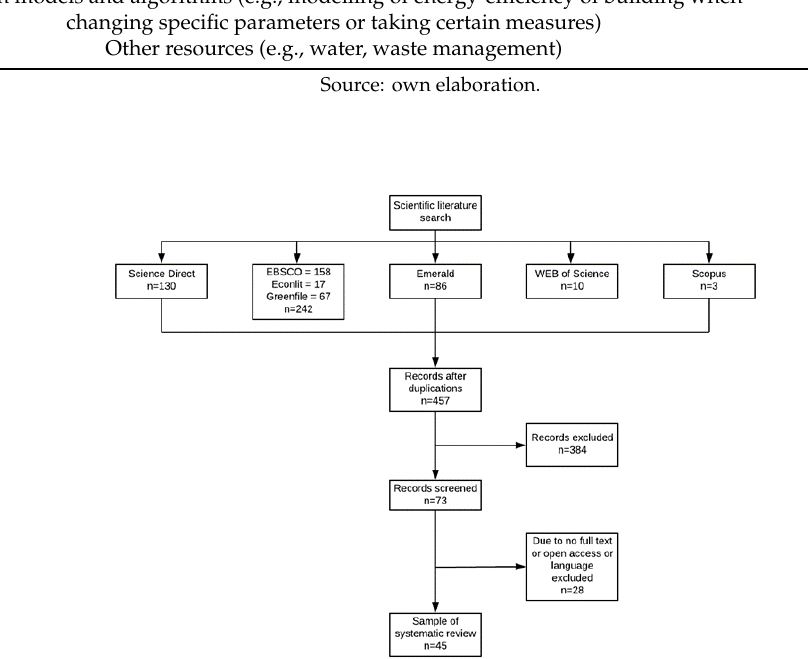
Figure 1. Flow diagram of the review process. Source: own elaboration.